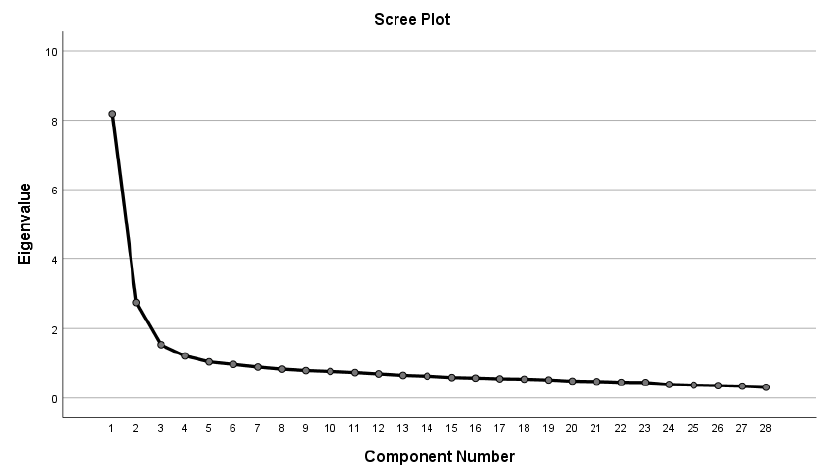
Figure 1. Scree plot of exploratory factor analysis. The analysis was repeated, and the number of factors to be extracted was limited to three. Three factors represented 44.49% of the variance, with factors 1, 2, and 3 contrib- uting 29.22%, 9.79%, and 5.47%, respectively. Varimax rotation was used to interpret the factors. The results of the factor analysis are presented in Table 2. Item 2 was removed because the load on each factor was <0.3. Factor 1 was similar to the avoidance factor of the original FSA scale and consisted of 13 items that expressed the intention to avoid older people. This factor was labeled ‘ Avoidance ’ in the present study. Factor 2 was labeled ‘ Ste- reotype ’ and was somewhat similar to the ‘ Antilocution ’ factor of the original FSA scale. Factor 2 consisted of seven statements describing respondents’ beliefs about older people. The third factor consisted of seven items with positive emotions towards older people; therefore, it was labeled as ‘ Positive emotional attitude ’. This factor, in comparison, was dif- ferent to the third factor of the original FSA scale, but similar to the third factor found by [34], the ‘ Affective attitude ’ factor (Table 3). Table 2. Item loadings of the principal component analysis and factor structure. Table 1 Item Loading for